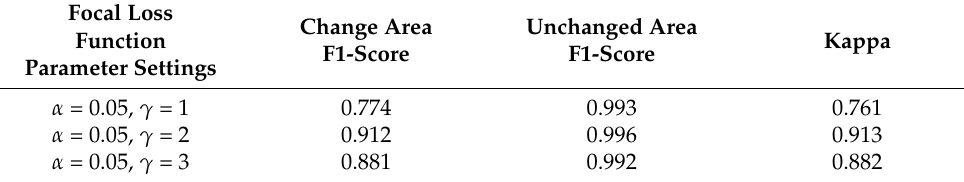
Table 3. Accuracy evaluation of the γ model for determining